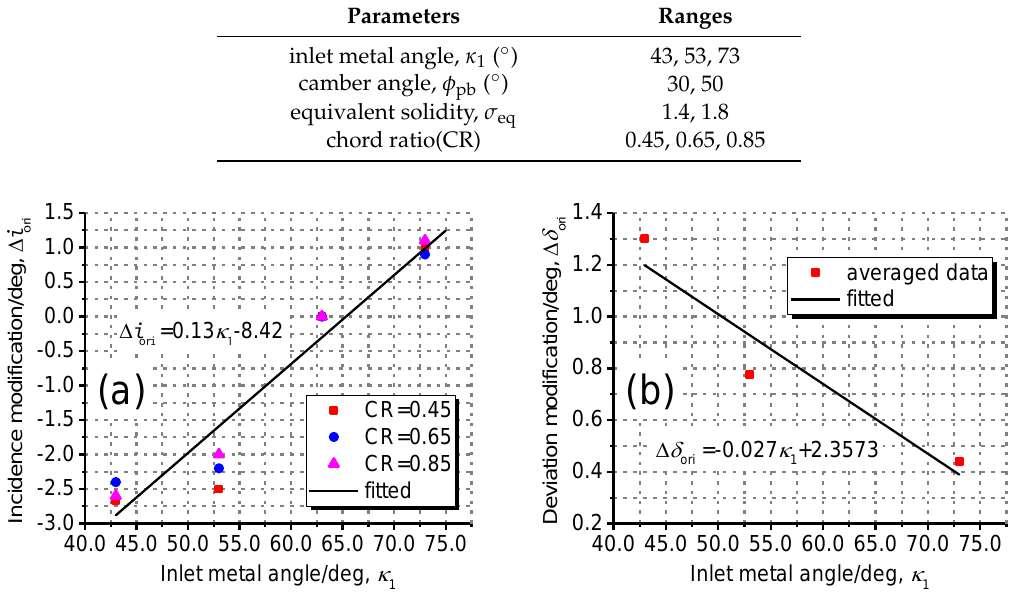
Figure 13. Averaged modifications for ( a ) incidence and ( b ) deviation angle correlations.